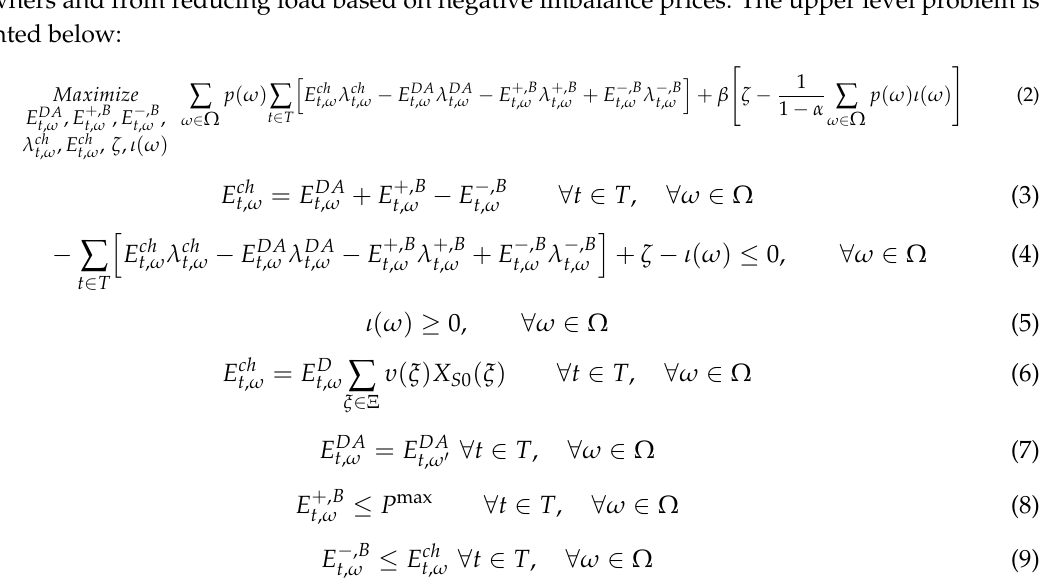
Figure 2. The probablity density function corresponding to the forecasted errors of rival aggregators ′ prices.